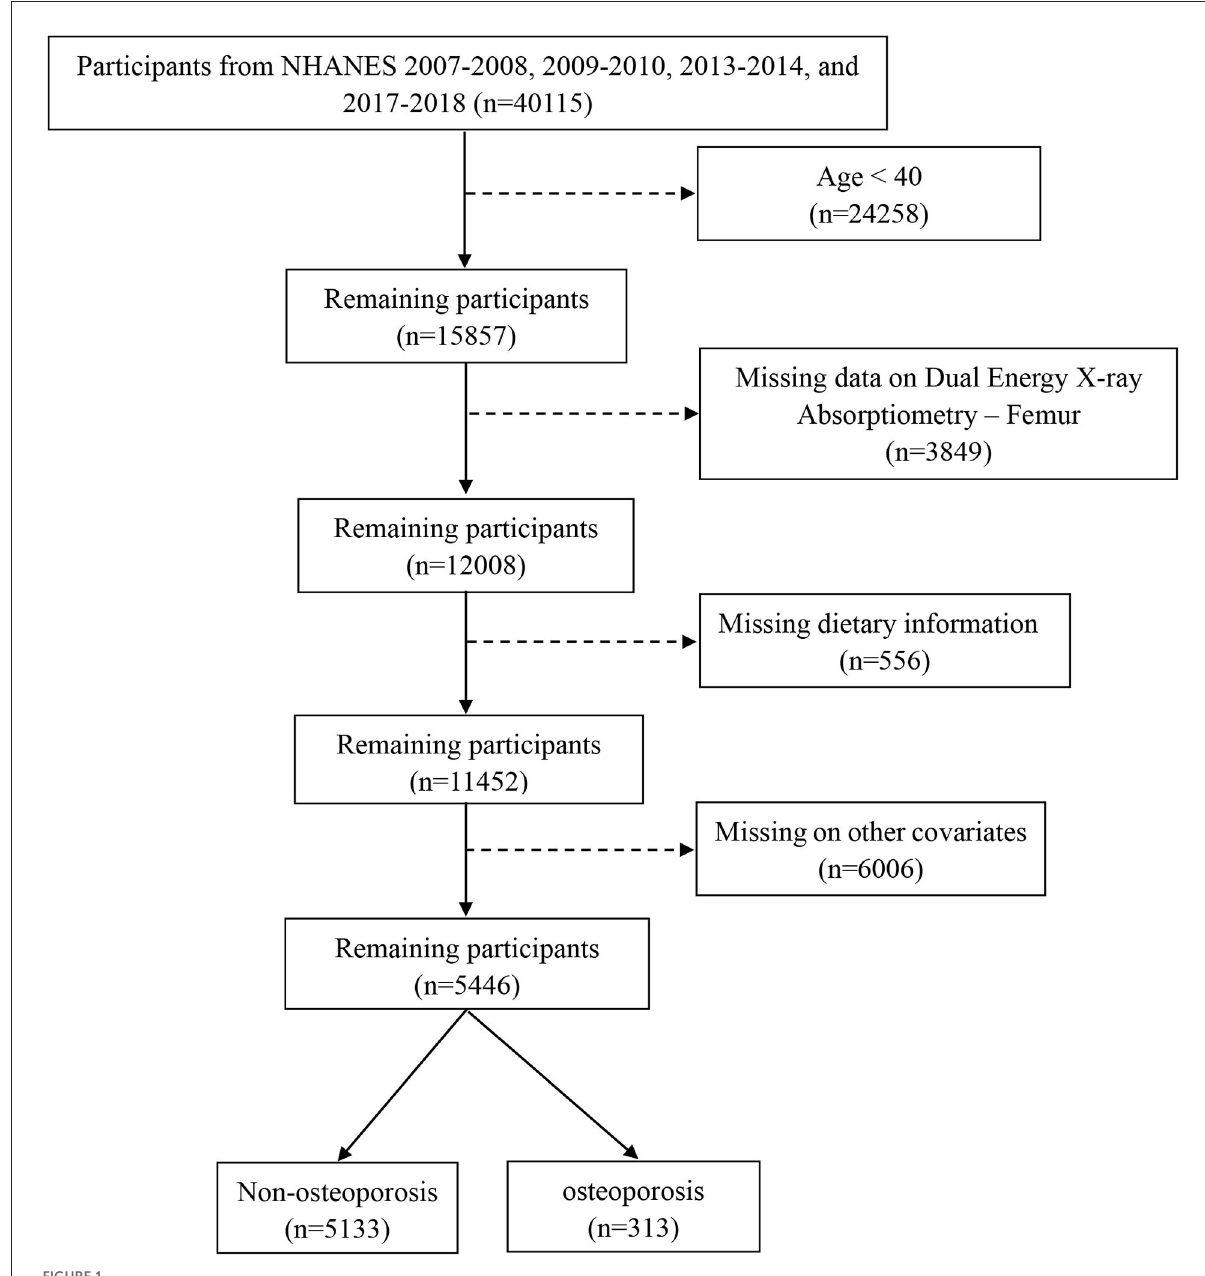
FIGURE1 The flowchart of this study. Data from NHANES 2007–2018 survey cycle, except for 2011–2012 and 2015–2016. Analysis was restricted to adults > 40 years of age with an examination for dual-energy X-ray absorptiometry femur bone data and a dietary interview. Exclusion criteria included those under 40 years, missing data on dual-energy X-ray Absorptiometry-Femur, dietary information, and incomplete other covariates.